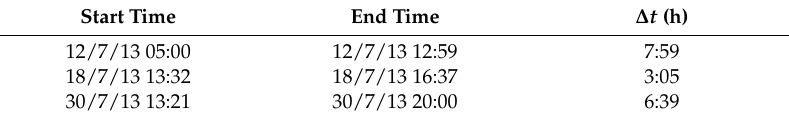
Table 2. Start and end time (solar time) of the proximity sensing